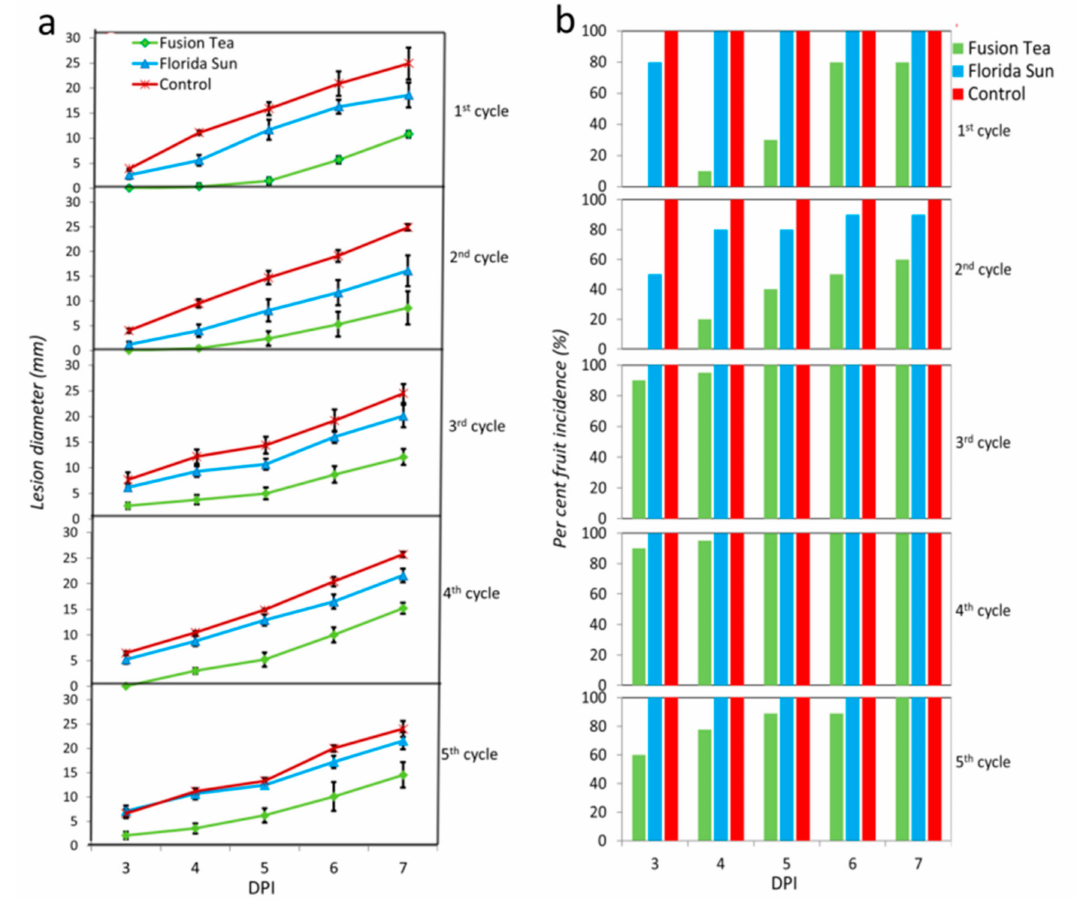
Figure 6. Biological activity of enrichment cultures of Florida Sun and Fusion Tea kefir grain samples ( a —lesion diameter of the wounds; b —per cent wound infected). Fruit were treated with suspensions of kefir grains and inoculated 2 h later with Penicillium expansum (10 5 spores ml − 1 ) or 20 µ L sterile distilled water in control and measurements were taken at 3, 4, 5, 6, and 7 days post inoculation (DPI). Bars indicate standard errors of the